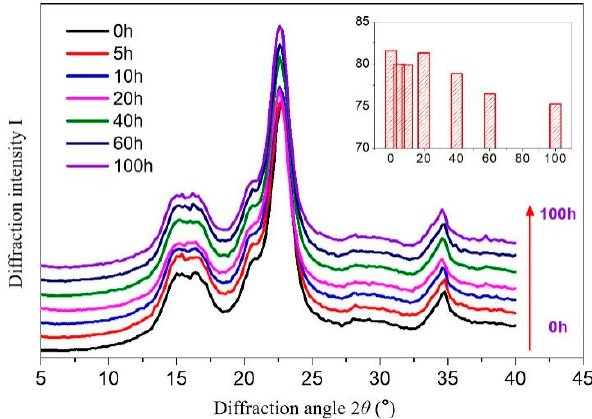
Figure 3. Relative crystallinity of dyed holocellulose during UV irradiation.